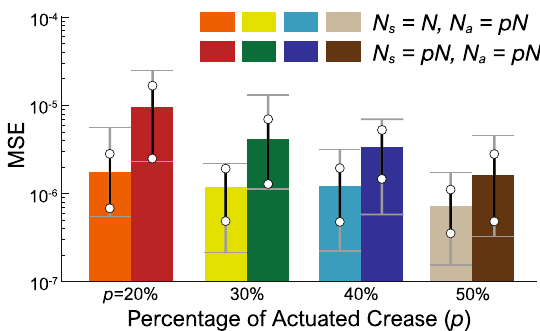
Figure 9. Effect of varying the number of actuator and sensor